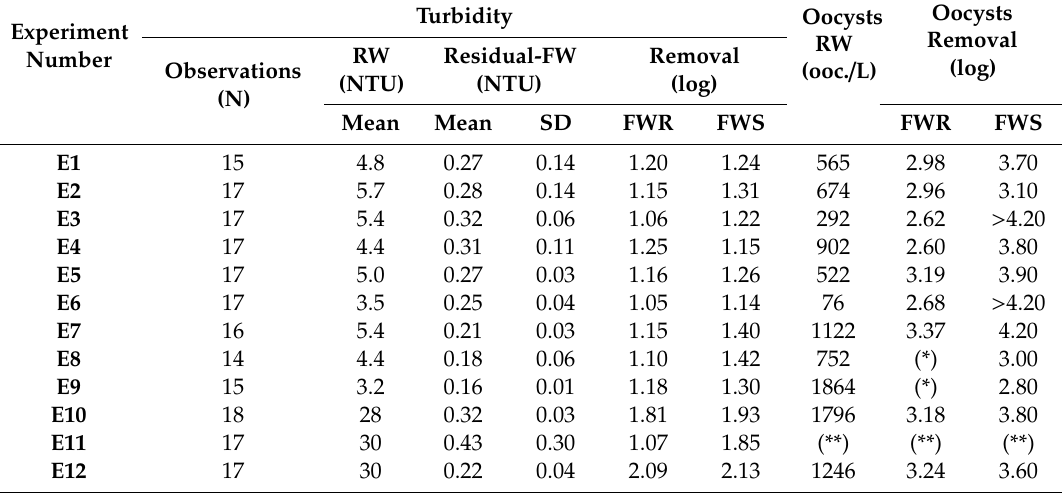
Table 1. Turbidity and Cryptosporidium oocysts values and log removals in the upflow direct filtration